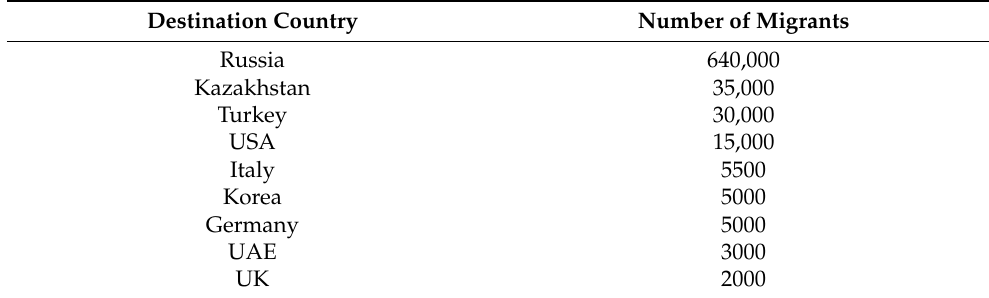
Table 2. Most common destination countries by number of migrants from the Kyrgyz Republic (Department of External Migration